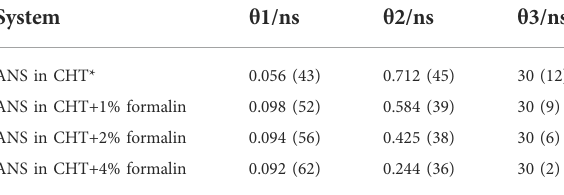
TABLE 4 Time-resolved Fluorescence anisotropy parameters.